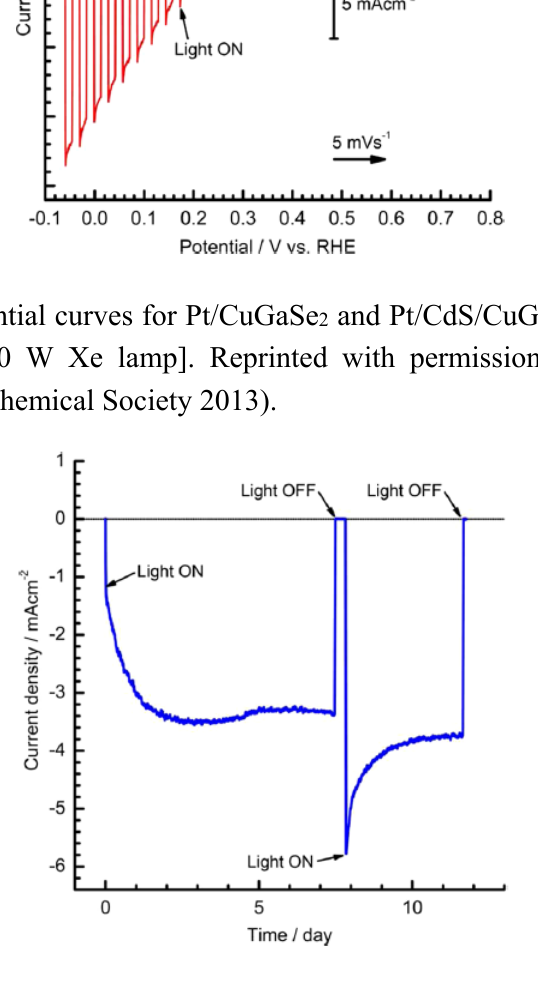
Figure 2. Current-time curve for a Pt/CdS/CuGaSe 2 electrode [0.05 M Na 2 HPO 4 (aq) + 0.05 M NaH 2 PO 4 (aq), pH 7, 150 W Xe lamp, 0 V RHE ]. Reprinted with permission from Reference [42] (Copyright American Chemical Society